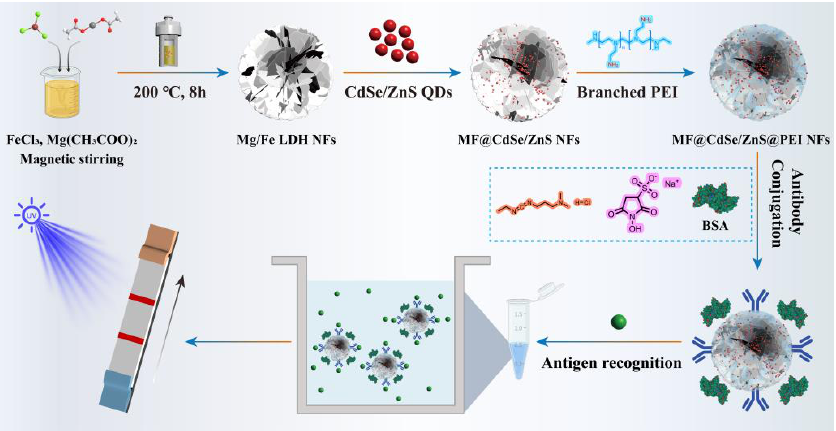
Figure 1. Schematic illustration of MF@CdSe/ZnS@PEI-ICTS for HCG